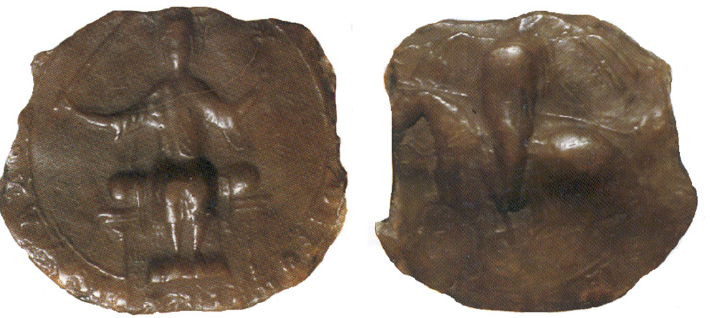
Figure 2. Wax seal of Alphonse II (no date). Obverse and reverse. Published by Reyes de Aragón ; Centellas R. (coord.), Ed., p. 69. Centellas R. (coord.), Ed., p.